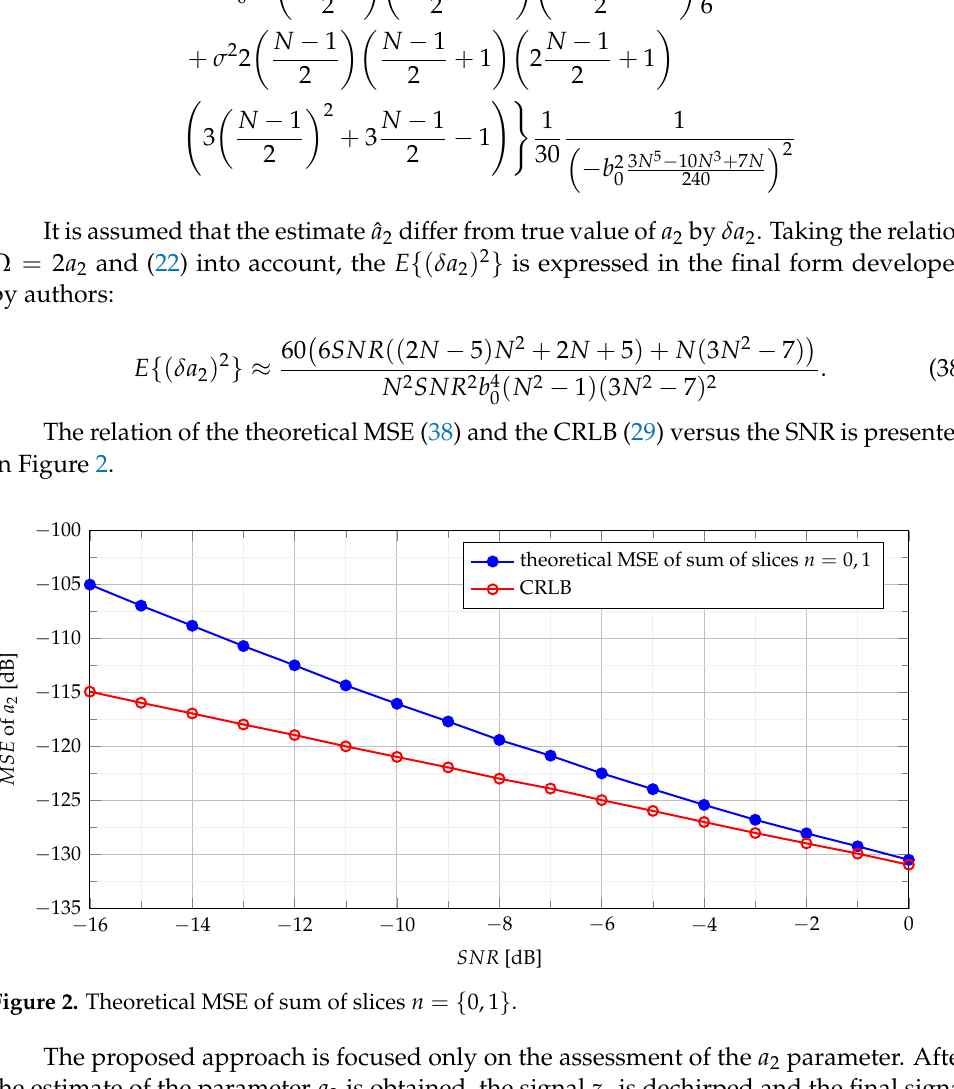
Figure 2. Theoretical MSE of sum of slices n =